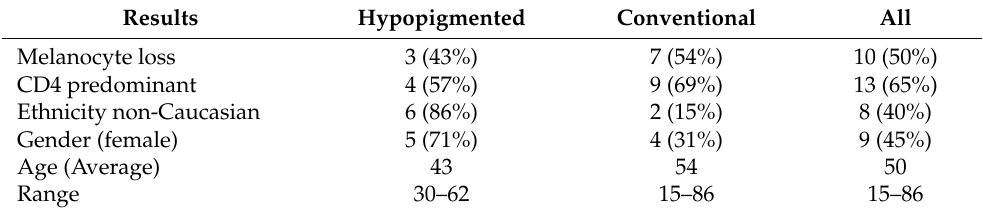
Table 1. Analysis of 20 cases of mycosis fungoides with features observed in hypopigmented and conventional cases.